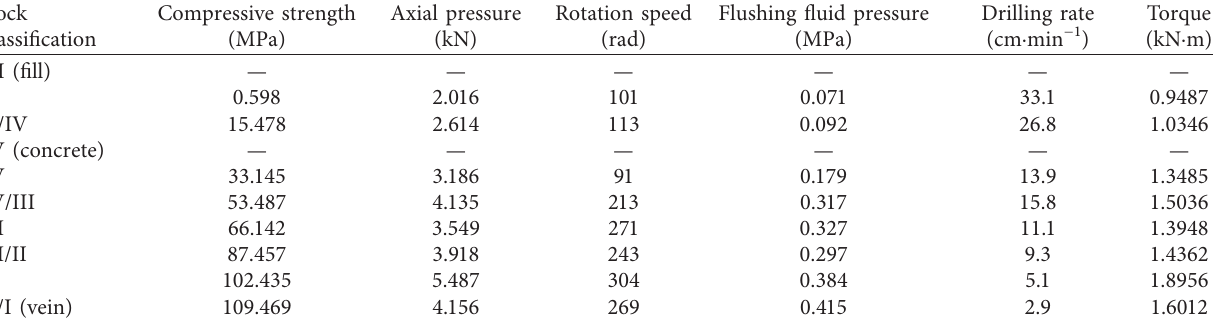
Table 12: Drilling parameters of hole